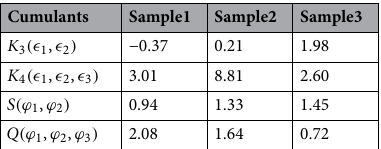
Table 3. Generalization of the cumulant